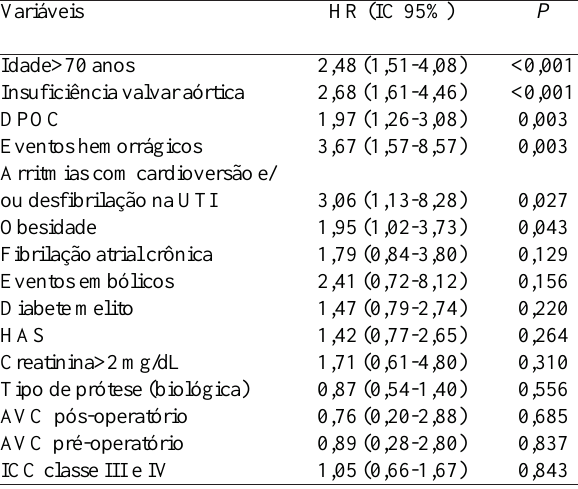
diferença estatisticamente significativa na sobrevida dos pacientes dos dois grupos ( P =0,939) ao longo do seguimento.